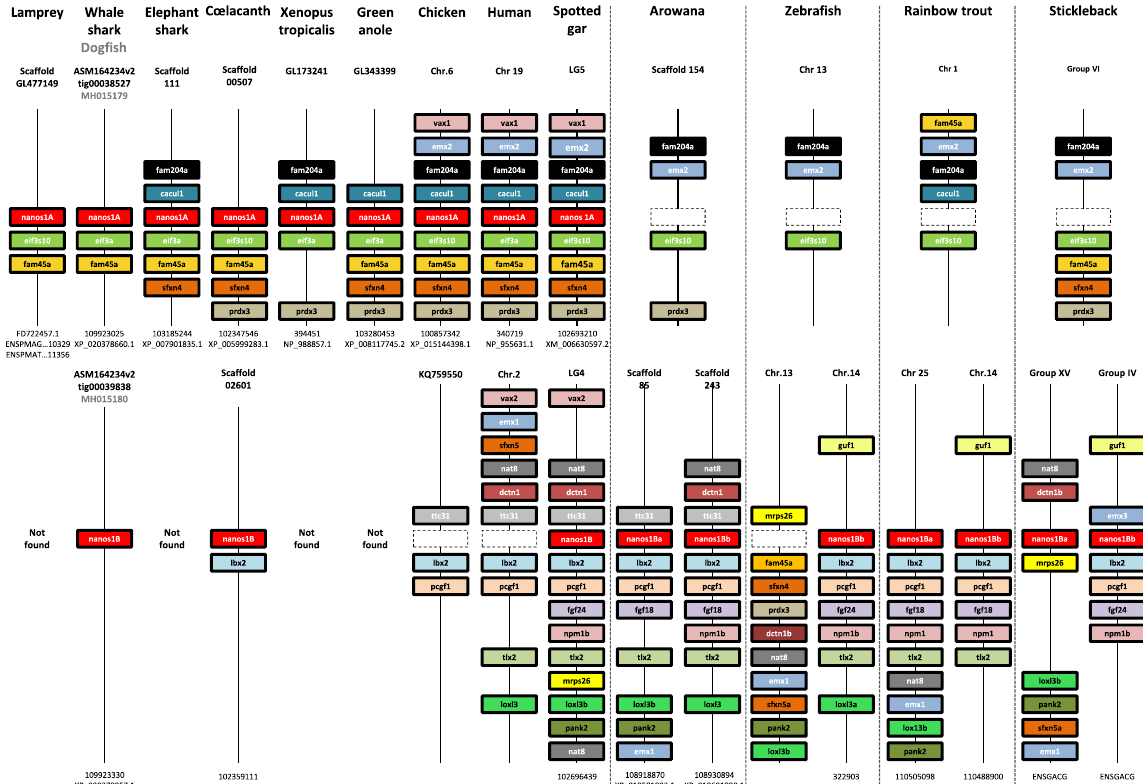
Figure 1. Gene synteny comparisons provide evidences that multiple nanos1 gene duplications and losses occurred in vertebrates Three nanos1 paralogs and their neighbouring genes showed syntenic genomic locations through Vertebrates. In the top panel, genes in the vicinity of a first copy, named nanos1A , were mapped. The figure was not drawn to scale. Each gene was represented by a specific coloured box. The name of each scaffold or chromosome harbouring the synteny is indicated at the top for each species whereas nanos1 gene copy and protein accession numbers are detailed at the bottom. Although the structure of the chromosomal fragment was well conserved during the evolution, the nanos1A gene copy is not observed in the genome of Teleost fish as symbolized by the dotted boxes. In the bottom panel, the genomic environment of the second nanos1 gene copy, termed nanos1B , was similarly represented. This different syntenic chromosomal fragment was not found in lamprey suggesting its apparition in Gnathostomata. Both nanos1 paralogs ( nanos1A and nanos1B ) were detected In Chondrichthyes (dogfish and whale shark) and in Osteichthyes, respectively at the basis of Sarcopterygii (coelacanth) and of Actinopterygii (spotted gar). In contrast, nanos1B gene was not found in elephant shark, xenopus, green anole, chicken and human, suggesting its loss in these species. Teleosts showed two nanos1B gene copies carried by similar but distinct chromosomal fragments. The two nanos1 paralogs in Teleosts were re-named nanos1Ba and nanos1Bb . Note that zebrafish is an atypical fish species because its genome does not harbour the nanos1Ba gene copy as indicated by a spotted